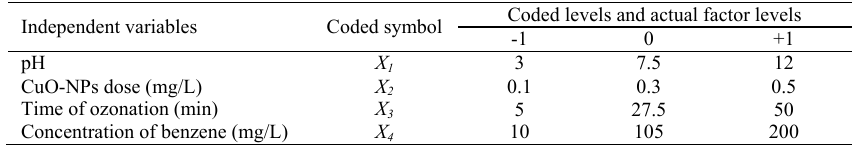
Table 1: Experimental range and level of the independent variables